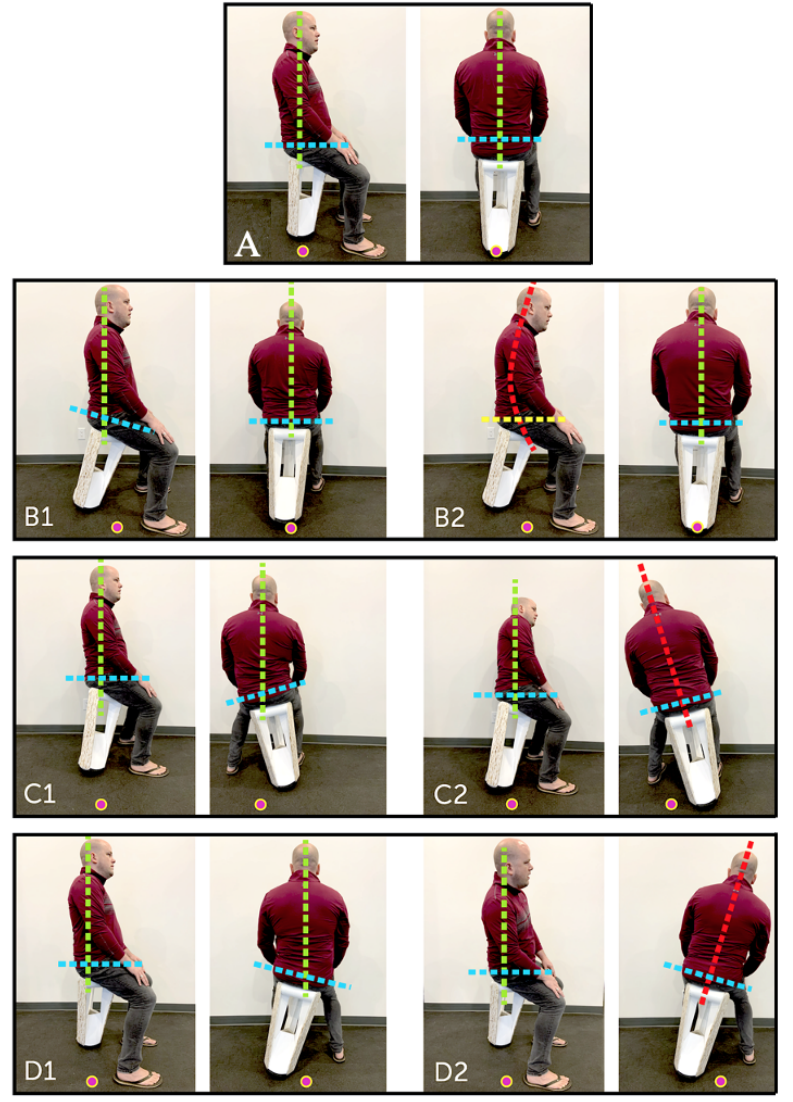
Figure 4. A side view ( left panel) and rear view ( right panel) of a variety of postures included in the study. ( A ) Neutral seat position, body aligned with gravity. ( B1 ) Forward seat position, body aligned with gravity. ( B2 ) Forward seat position, body aligned with gravity and slouched. ( C1 ) Left seat position, body aligned with gravity. ( C2 ) Left seat position, body not aligned with gravity. ( D1 ) Right seat position, body aligned with gravity. ( D2 ) Right seat position, body not aligned with gravity. COLOURS: Green: spine aligned with gravity. Red: Spine not aligned with gravity or slouched. Blue: Hips aligned to seat. Yellow: Hip delaminating from seat. Dot: Approximate center of gravity projected